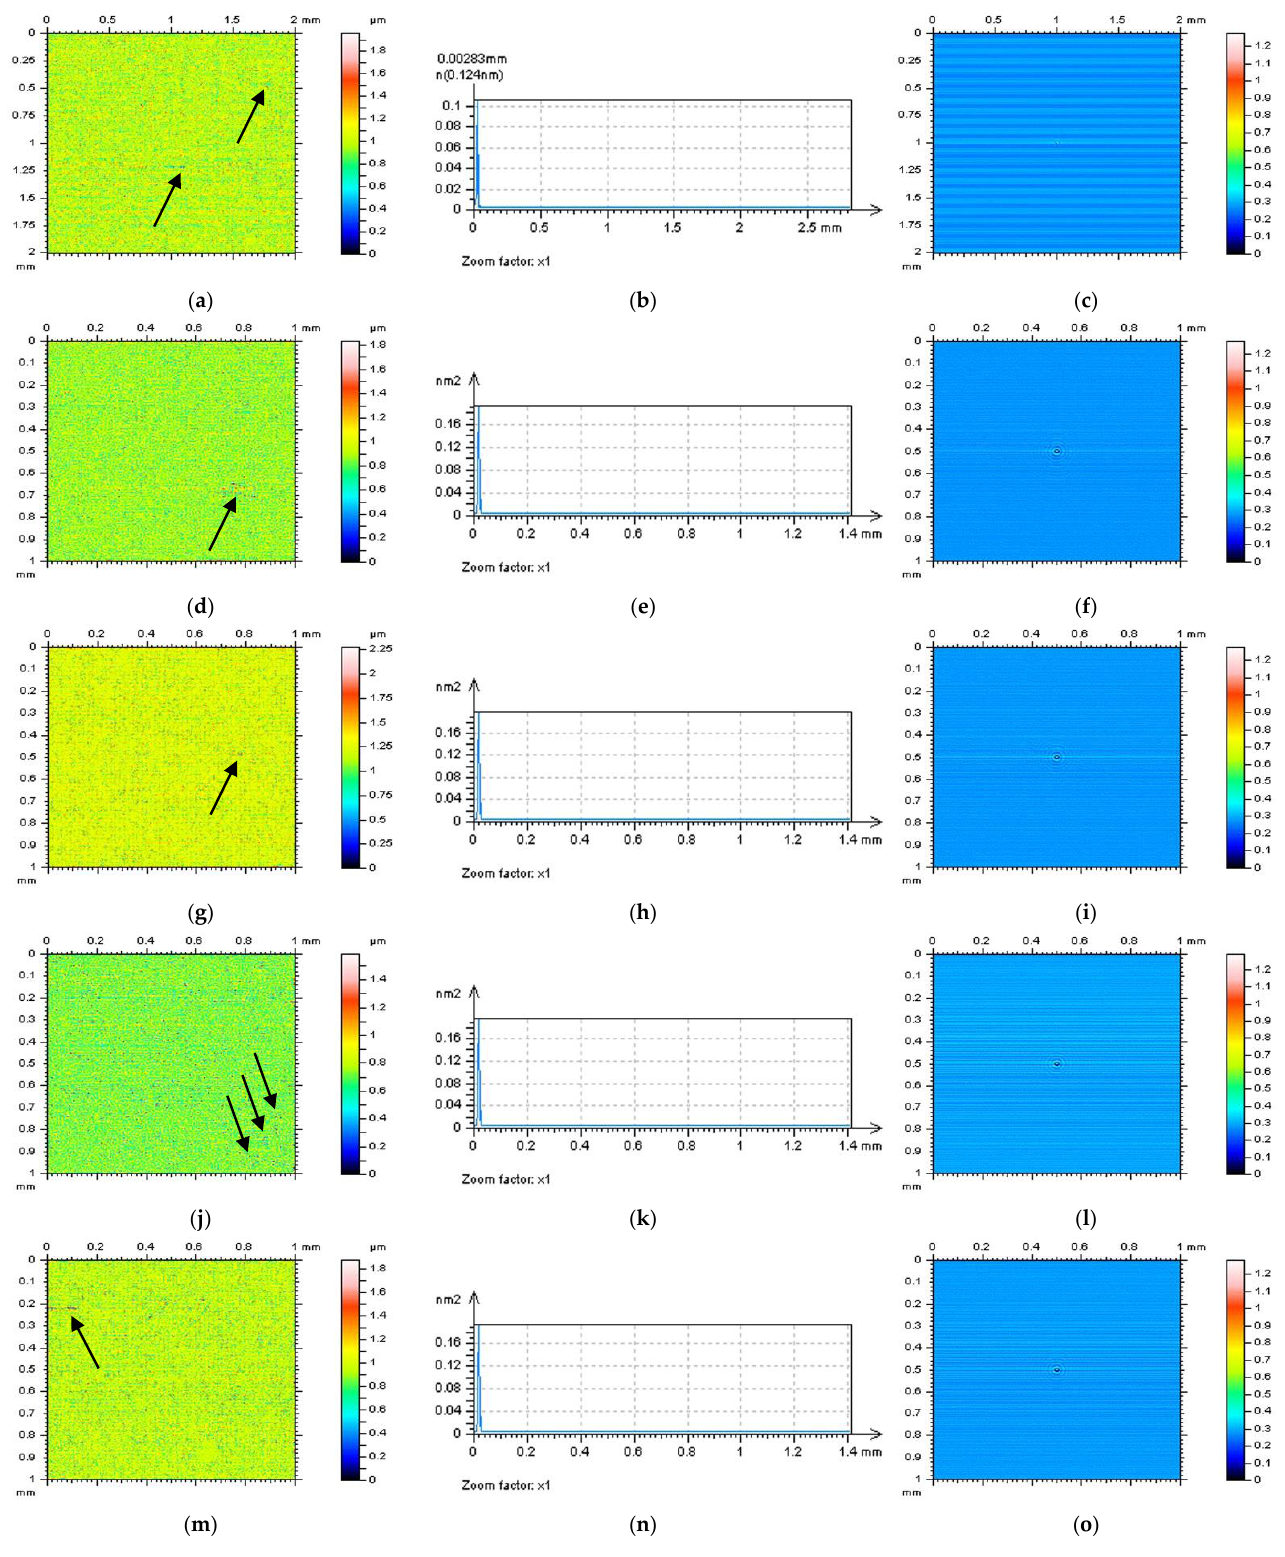
Figure 8. Contour map plots (left column), its 3D PSDs (middle) and ACFs (right column) of NS received by application of the FFTF method (cut-off = 0.015 mm) from the measured surface ( a – c ) and surfaces: E ( d – f ), F ( g – i ), G ( j – l ), and H ( m – o ) extracted from a turned topography. The features which are not classified as the noise (like scratches, dimples, wholes), were presented by arrows.